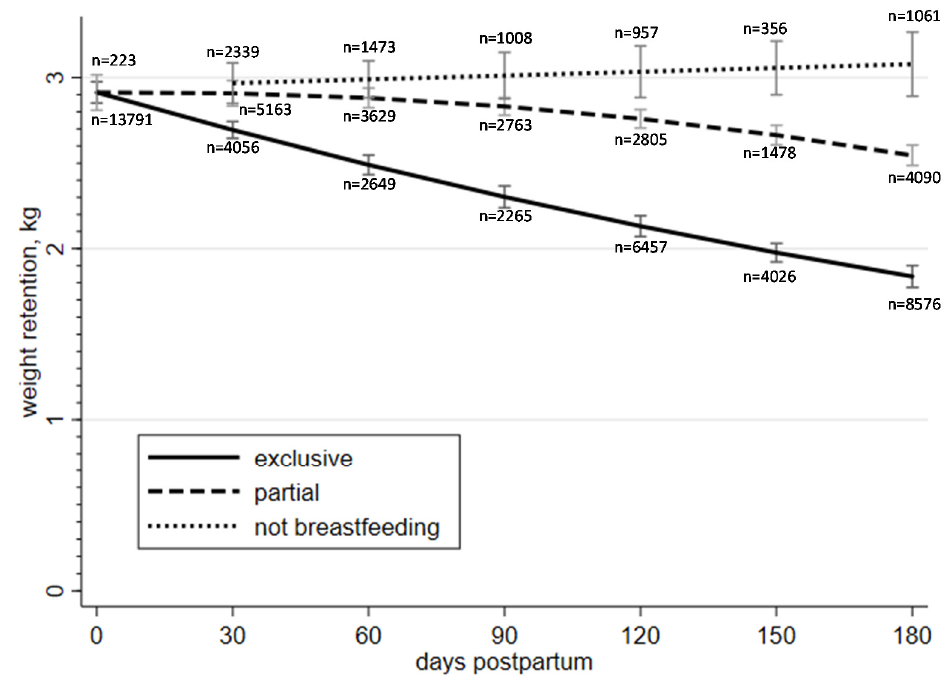
Figure 1. Adjusted means and 95% confidence intervals of postpartum weight retention and duration of breastfeeding in Taiwanese women ( N = 52,367). Notes: (1) postpartum weight retention was assessed at 7–14 months postpartum; (2) X-axis represents duration of breastfeeding in days postpartum; (3) each time point on the same curve represents different women; (4) exclusively breastfeeding women that started adding food, liquids or formula are represented at a later time point on the curve for partial breastfeeding; (5) women that ceased breastfeeding completely are represented at a later time point on the curve for no breastfeeding; (6) sample sizes do not sum up to the total because of the cross-sectional design of the study.